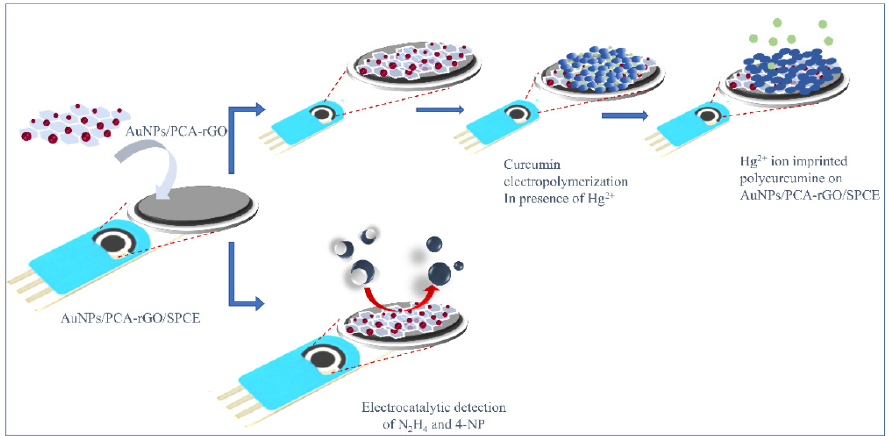
Figure 5. Scheme of the sensing approaches investigated in the work for the electrocatalytic detec ‐ tion of N 2 H 4 and 4 ‐ NP by the AuNPs/PCA ‐ rGO/SPCEs, and for the determination of Hg 2+ ions by the IIP/AuNPs/PCA ‐